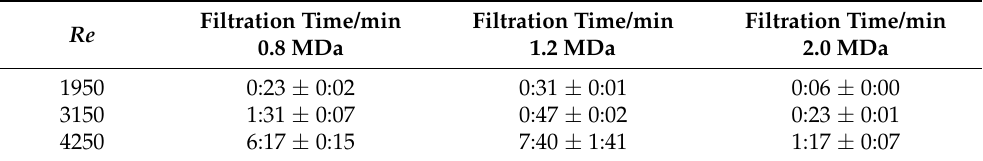
Table 3. Representative filtration times (step of fibre suspension filtration during the textile prepara- tion) measured for various Re and M W of HA.